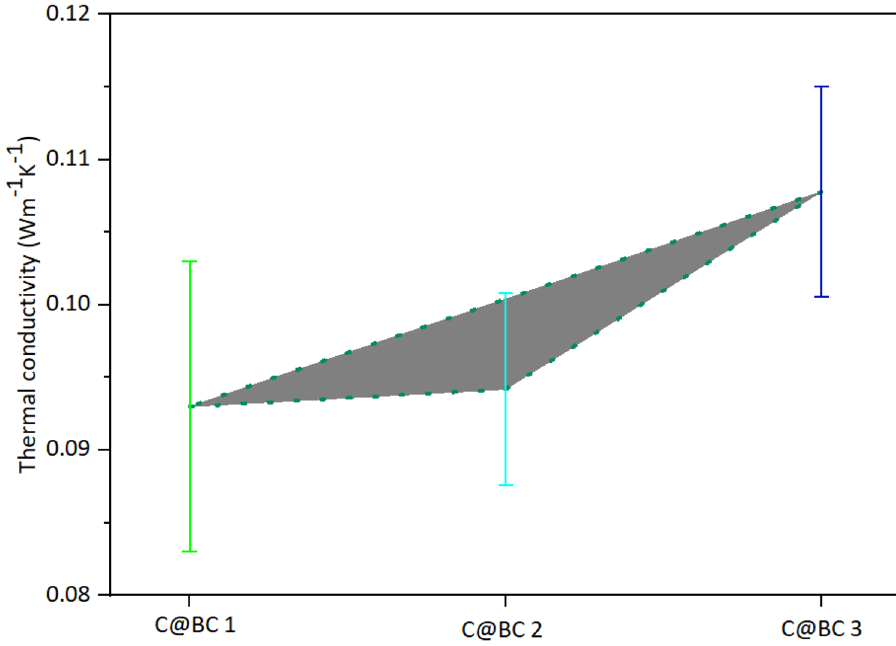
Figure 8. Thermal conductivity of ( a ) control coir, ( b ) C@BC 1, ( b ) C@BC 2, and ( b ) C@BC